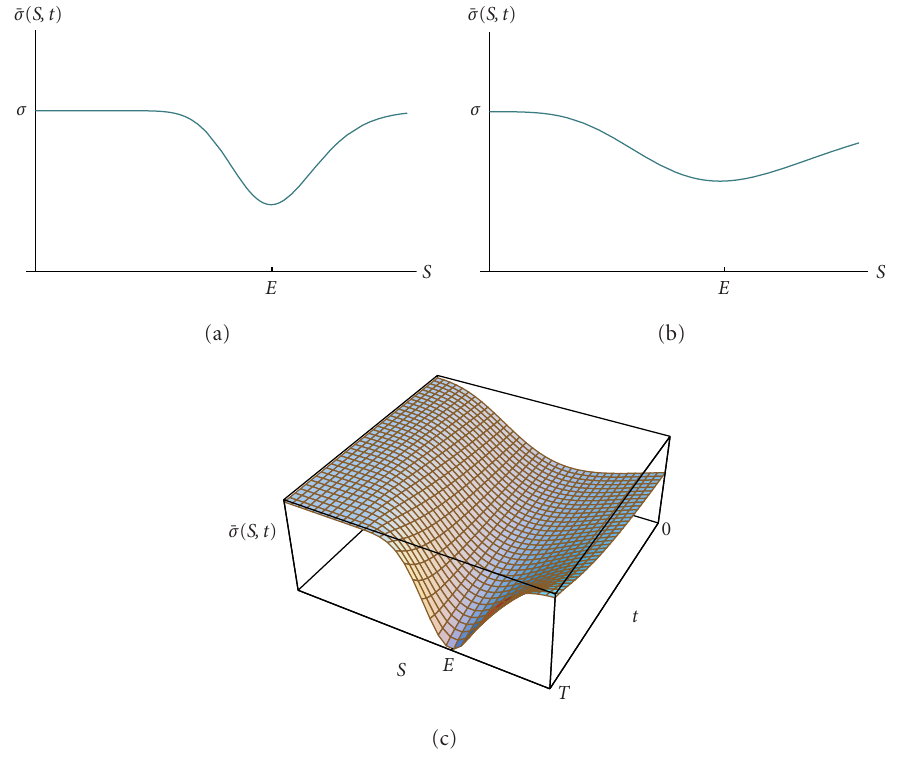
Figure 5.1. Explanation of the volatility smile. Dependence of ¯ σ ( S , t ) on S is depicted in (a) for t close to T and in (b), for a time 0 < t (cid:6) T . The mapping ( S , t ) (cid:4)→ ¯ σ ( S , t ) is shown in